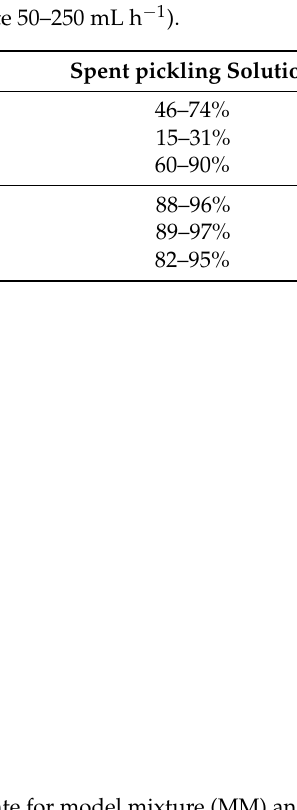
Figure 2. Dependence of recovery on volumetric liquid flow rate for model mixture (MM) and spent pickling solution (SPS). pickling solution